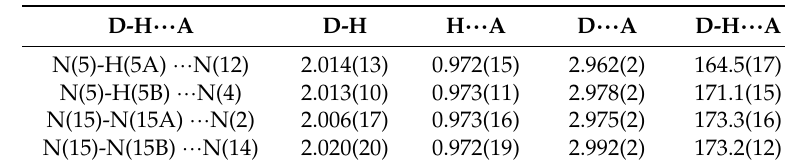
Table 1. Hydrogen bonding parameters for 1 (Å, °).